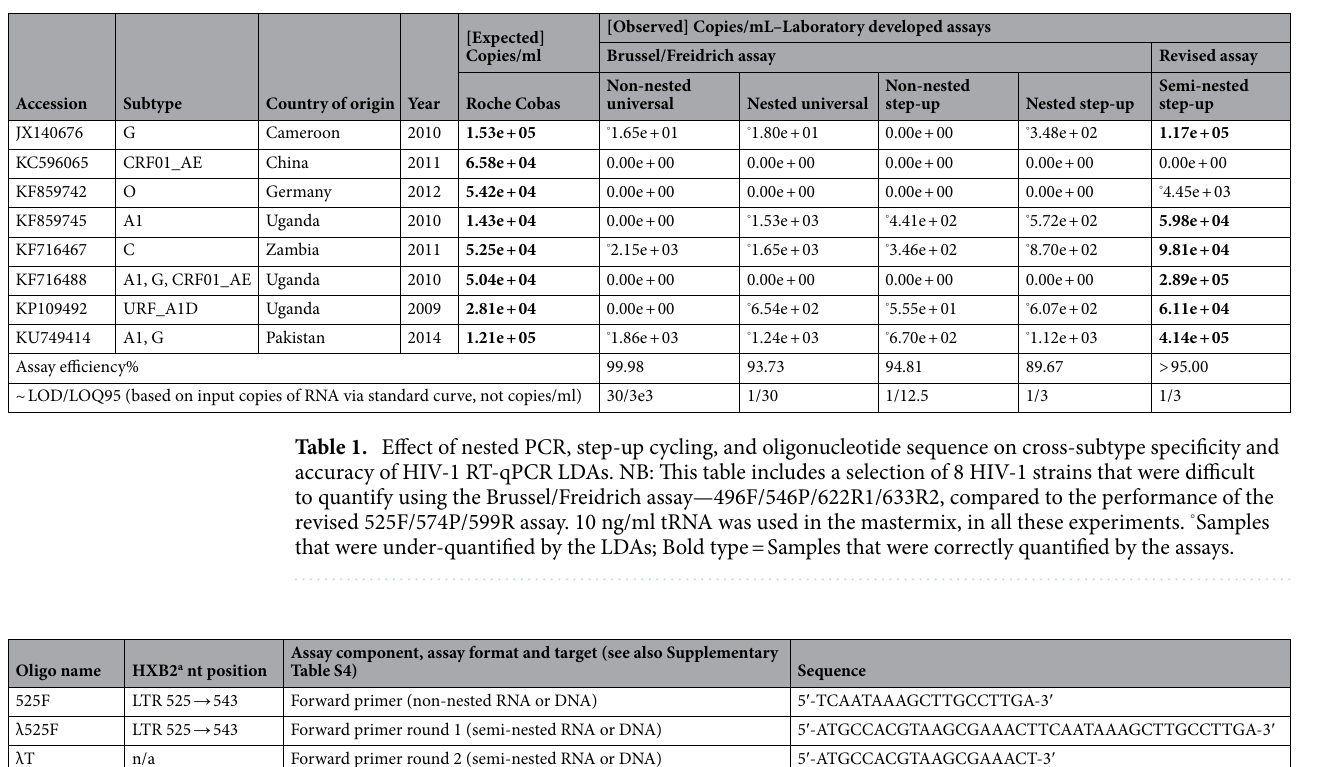
better than the QuantiFast™ Probe (Qiagen) and Kapa Probe Fast (Merck), providing a significant time and cost saving from the previously used Qiagen QuantiTect Probe kit. Reverse transcriptase quantitative PCR (RT‑qPCR) protocol for RNA targets. Standard non-nested RTqPCR. The standard non-nested format of the RTqPCR or viral load assay was adapted to the 1-Step Go mastermix (PCR